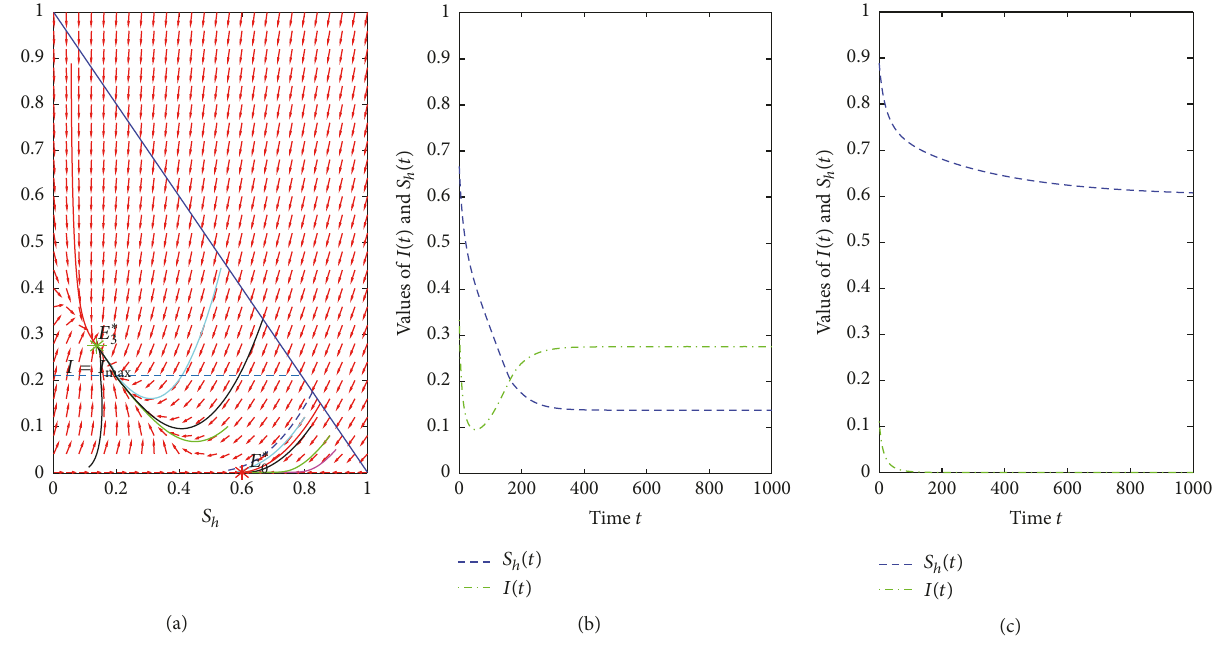
Figure 4: Trajectory figure and time plots of Example 2.